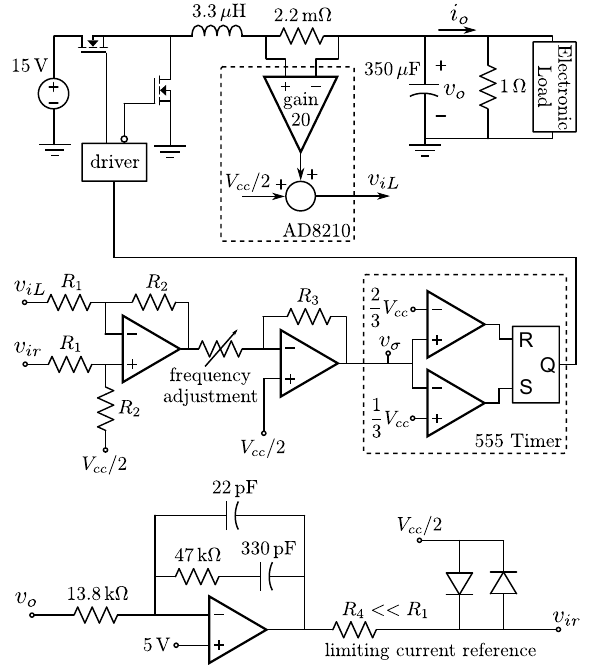
Figure 12. Schematic circuit diagram of the buck converter with hysteretic CMC and output voltage regulation. The frequency response of the system being the input ˆ v ir and the output ˆ v o , in the case of an open voltage loop, has been obtained experimentally, and it is depicted in Figure 13 with the Bode diagram of G vir ( s ) / R s . The experimental frequency response in Figure 13 was obtained by using the Venable 3120 FRA. In this particular case, the analog control circuit is the one in Figure 12; with the voltage loop opened, the FRA provides the voltage reference v ir , which is composed of a sinusoidal variable frequency reference and a DC component to polarize the system around the desired steady-state operating point. Closed loop gains in Figure 14 were obtained in closed loop using also the Venable 3120 FRA; in this case, a wideband medium frequency injection transformer model Bode Box 200-002 and two probes to obtain differential measurements are connected to the R4-100 Ω resistor.